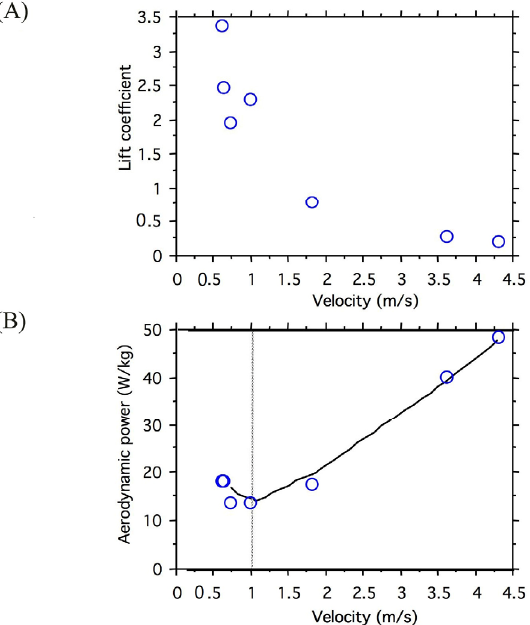
Figure 5. ( A ) Lift coefficient relative to forward velocity for H. sara butterflies; ( B ) Aerodynamic power relative to forward velocity for Heliconius sara butterflies. Each point represents a different butterfly. The dotted line is drawn at the minimum power velocity (V mp ).